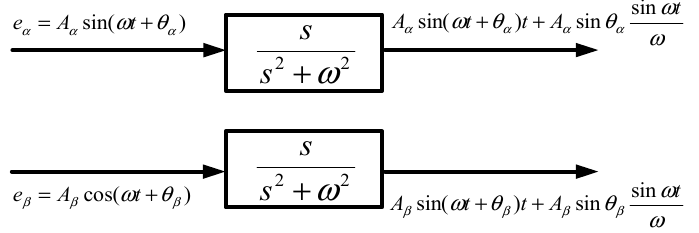
Figure 8. Integral of alpha and beta axis.